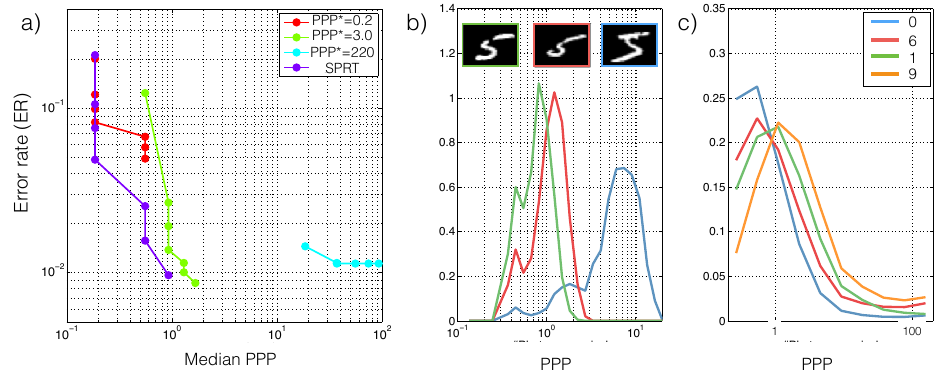
Figure 3. Low-light classification performance. ( a ) Error rate vs . PPP tradeoff for the SPRT algorithm (Equation (3)). PPP ∗ = x denotes a “specialist”: A model trained using images only at light level x and tested on other light levels by input normalization (see Section 2.2.2). ( b ) SPRT